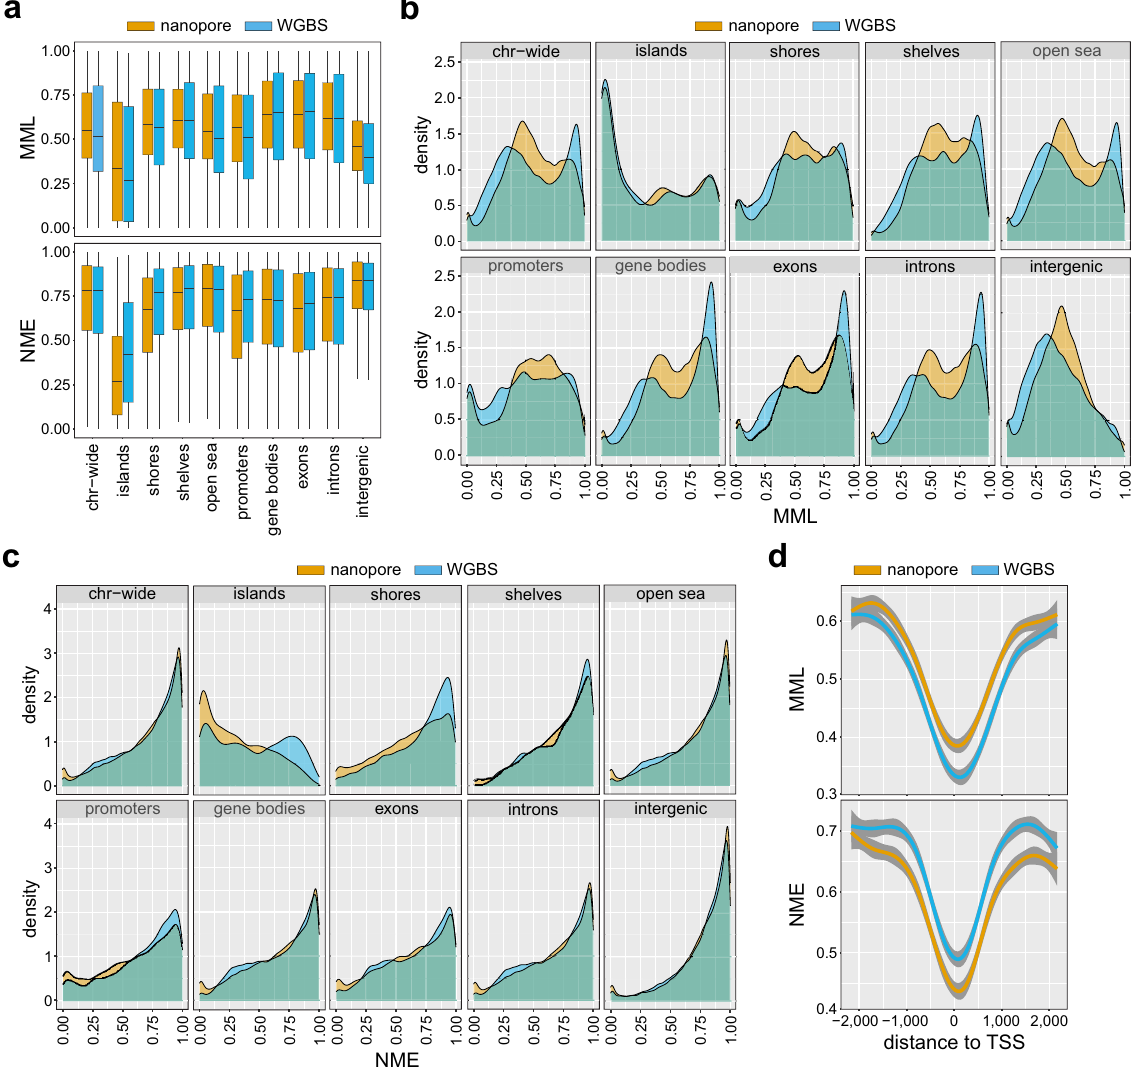
Figure 2. Distributions of methylation levels and entropies in the Utah/Ceph lymphoblastoid cell line. ( a ) Boxplots depicting distributions of mean methylation level (MML) and normalized methylation entropy (NME) values over selected genomic features of the human genome (Chr. 22), estimated from nanopore (brown) and WGBS (blue) data associated with the human Utah/Ceph lymphoblastoid cell line. Center line of box: median value; box bounds: 25th and 75th percentiles; lower whisker: larger of minimum value and 25th percentile minus 1.5 × interquartile range; upper whisker: smaller of maximum value and 75th percentile plus 1.5 × interquartile range. ( b ) Densities of MML values; ( c ) Densities of NME values. ( d ) Aggregate (average) MML and NME values as a function of distance from the transcription start sites (TSSs) of